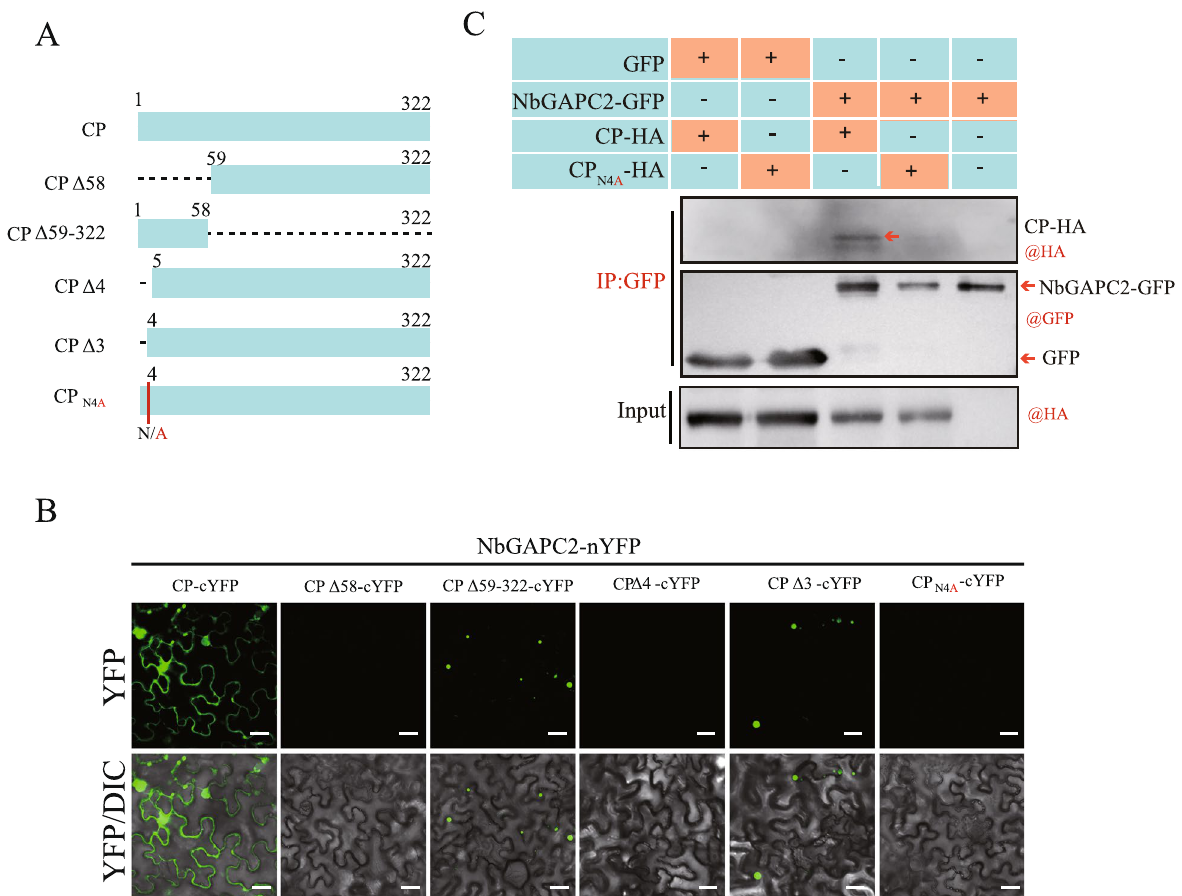
Fig. 3 The fourth amino acid (Asn) of CP is essential for binding to NbGAPC2. A Schematic representation of the CP mutants analyzed in this study. The amino acid positions of deletions and point mutations in the CP sequence are shown above the diagram. N/A indicates that Asn (N) was replaced by Ala (A). B BiFC assay to examine the interaction of NbGAPC2 and CP or CP mutants. NbGAPC2 and CP or CP mutants (CPΔ58, CPΔ59-322, CPΔ4, CPΔ3, and CPN4A) were fused to the N-terminal or C-terminal portions of the split yellow fluorescent protein nYFP or cYFPnd transiently co-expressed in N. benthamiana . The reconstituted YFP fluorescence in epidermal cells were observed by confocal laser scanning microscopy. Scale bars, 20 μm. C In vivo co-immunoprecipitation assay to examine the interaction of NbGAPC2 with CP or CP N4A . CP and CP N4A fused to an HA tag and NbGAPC2 fused to GFP were transiently expressed in N. benthamiana leaves, and immunoprecipitations were performed with an anti-GFP antibody. Protein samples before and after immunoprecipitation were analyzed by western blot with anti-HA and anti-GFP